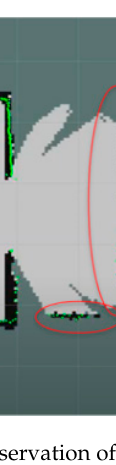
Figure 13. Observation of negative space in mirrored environments. Negative spaces are shown with red ovals.